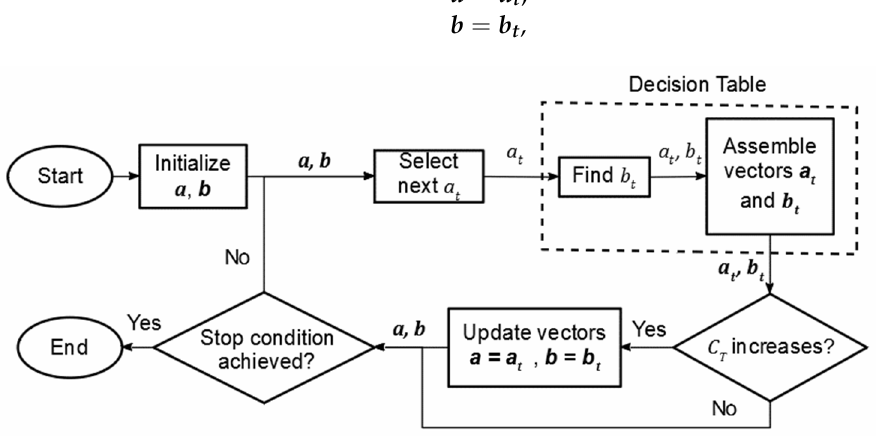
Figure 8. Optimization process based on iterative updating of vectors 𝒂 and 𝒃 .